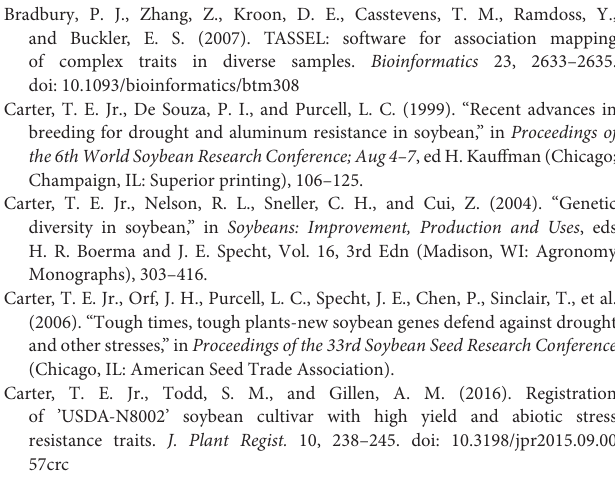
Supplementary Figure 4 | Frequency distribution for predicted canopy wilting scores for 19,648 soybean accessions in the USDA Soybean Germplasm Collection for maturity groups (MGs) 000 through X. Canopy wilting scores were predicted using genomic estimated breeding values that used training sets from the current research, Kaler et al. (2017a), and Steketee et al. (2020). Supplementary Table 1 | Planting dates, wilting rating dates, weather data, number of irrigations, and potential evapotranspiration rate for the drought treatment at six site years. a Cumulative potential evapotranspiration between emergence and last rating date. Supplementary Table 2 | Canopy wilting BLUP values used for GWAS analysis for twelve environments, Columbia (CO18), Maricopa (MC18 and 19), Pine Tree (PT18 and 19), Rohwer (RH18) under irrigated (IR) and drought (DR) treatments, and averaged across irrigated (Ave_IR) and drought (Ave_DR) treatments, and averaged across all environments (AAE). Supplementary Table 3 | Accessions identified as wilting slower or faster than slow-wilting (PI416937 and PI471938) and fast-wilting (A5959 and 08705_16) checks when averaged over irrigated (Ave_IR) and drought (Ave_DR) treatments. a Standard deviation values from analysis of variance for Ave_IR and Ave_DR were 6.8 and 8.9, respectively. Supplementary Table 4 | Correlations for canopy wilting ( n = 206) for Columbia (CO18), Maricopa (MC18 and 19), Pine Tree (PT18 and 19), Rohwer (RH18) irrigated (IR) and drought (DR) treatments, averaged over irrigated (Ave_IR) and averaged drought (Ave_DR) treatments, and averaged across all environments (AAE). Supplementary Table 5 | Predicted slowest and fastest wilting accessions of maturity group (MG) 000 through X using genomic estimated breeding values (GEBVs) from the USDA Soybean Germplasm Collection ( Song et al., 2015). The training set for the prediction of 19,648 accessions was determined using the averaged canopy wilting (CW) scores of 100 new accessions in the present study, 373 accessions reported by Kaler et al. (2017a), and of the 153 accessions reported by the Steketee et al. (2020). Supplementary Table 6 | List of significant coincident SNPs associated with canopy wilting and their potential candidate genes based on 87 identified SNPs from twelve environments for the irrigated and drought treatments, averaged over irrigated treatments (Ave_IR), average over drought treatments (Ave_DR), and averaged across all environments (AAE). Supplementary Table 7 | Significant novel SNPs associated with canopy wilting and their potential candidate genes based on 101 identified SNPs from twelve environments under irrigated and drought treatments, averaged across irrigated treatments (Ave_IR), averaged across drought treatments (Ave_DR), and averaged across all environments